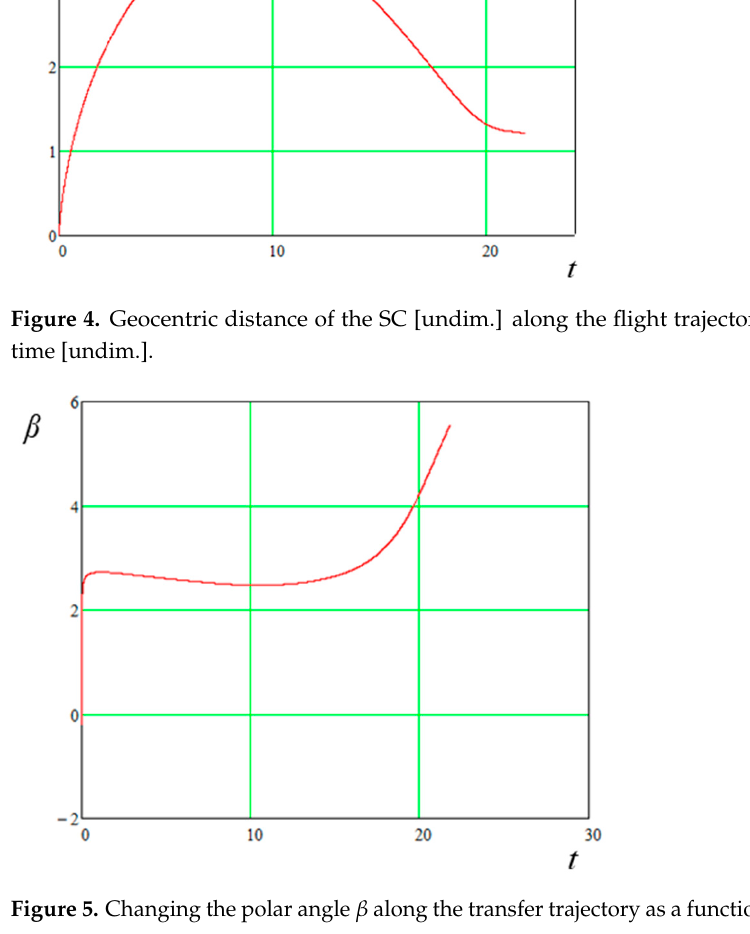
Figure 5. Changing the polar angle β along the transfer trajectory as a function of flight time [undim.].